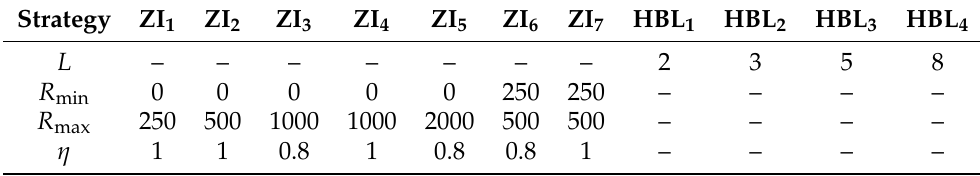
Table 1. Background trading strategies included in empirical game-theoretic analysis.